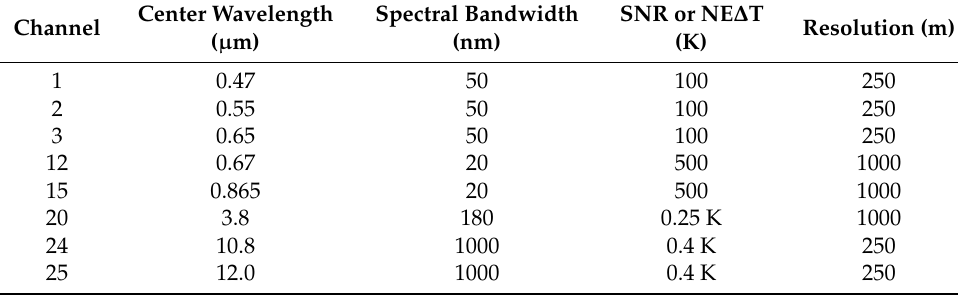
Table 1. Spectral characteristics of FY-3D MERSI.